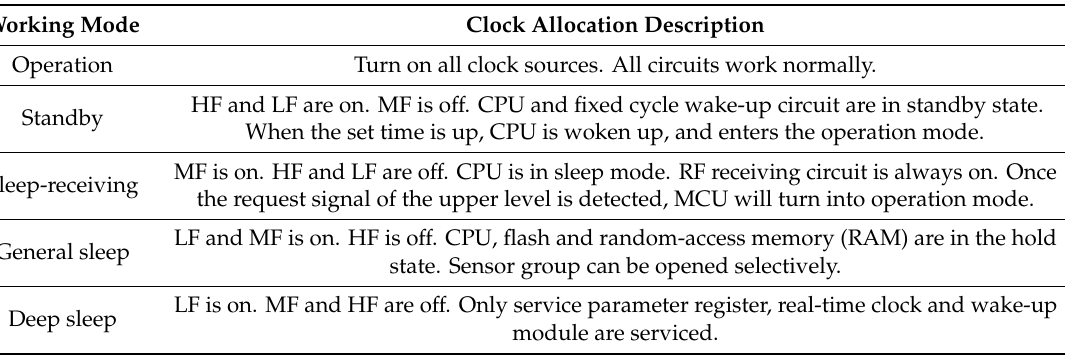
Figure 8. Clock frequency distribution diagram. LF—low frequency, MF—middle frequency, HF—high frequency. Table 1. Node clock allocation for different working modes.